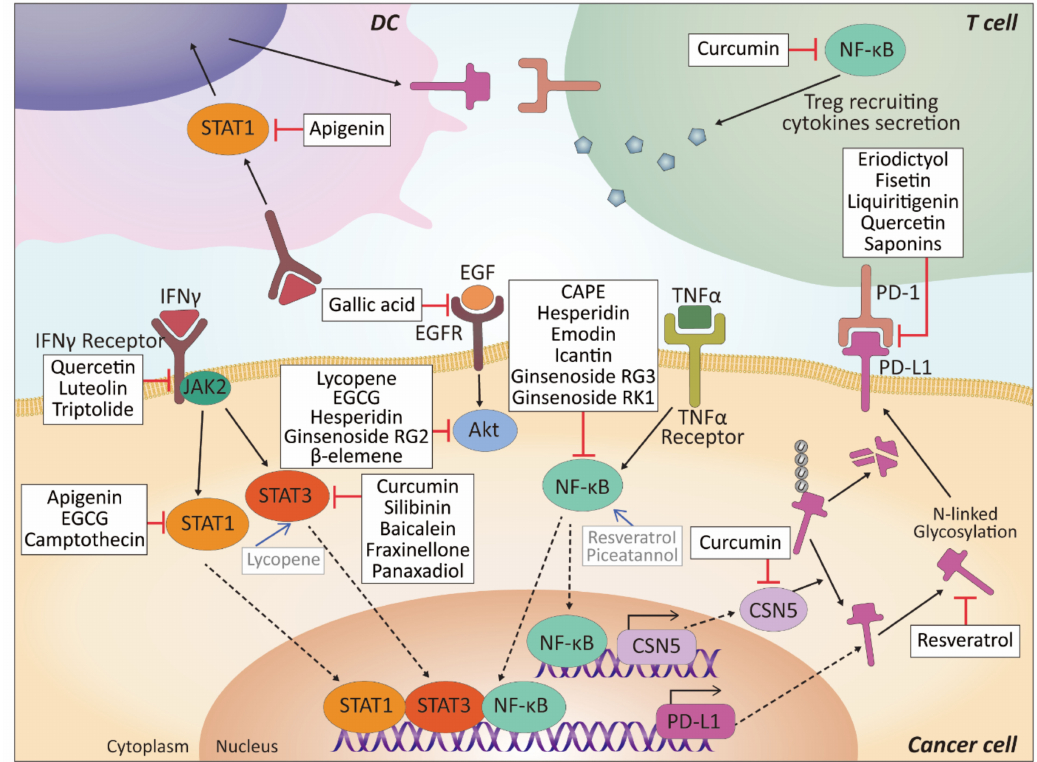
Figure 4. Schematic representation of signaling pathways regulating PD-L1 expression in cancer cell, dendritic cell (DC), and T cell targeted by bioactive phytochemicals. Phytochemicals modulate therapeutic effects of ICI and expression of PD-L1 through the regulation of multiple signaling pathways, including IFN- γ /JAK/STAT, EGFR/Akt, and TNF- α /NF- κ B signaling pathways. Many phytochemicals regulate PD-L1 expression by targeting pathways related to PD-L1 transcription and certain phytochemicals inhibit glycosylation of PD-L1 protein or PD-1/PD-L1 binding. Phytochemicals are listed in white or grey boxes. Arrows indicate activations; blunt-ended lines indicate inhibitory effects; dotted arrows indicate